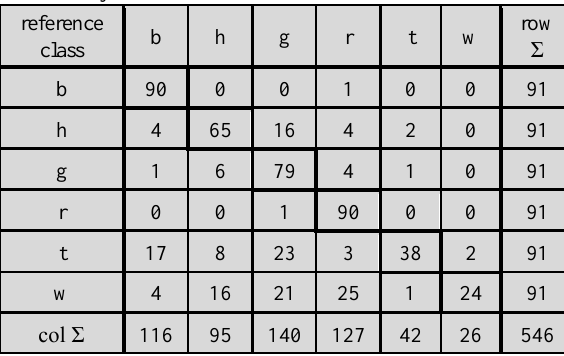
Table 5. Error matrix of the SVM-classification (abbreviations for classes are explained in the caption of Table